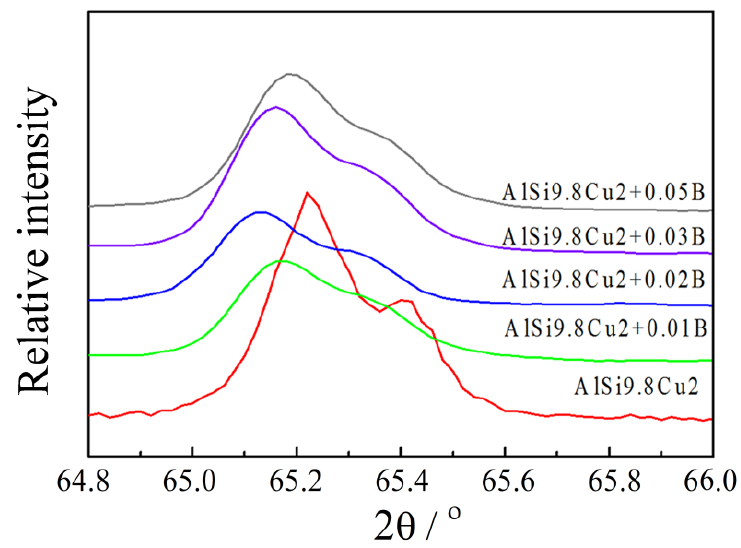
Figure 10. X-ray diffraction spectrums of the Al-9.8%Si-2%Cu aluminum alloys with different B